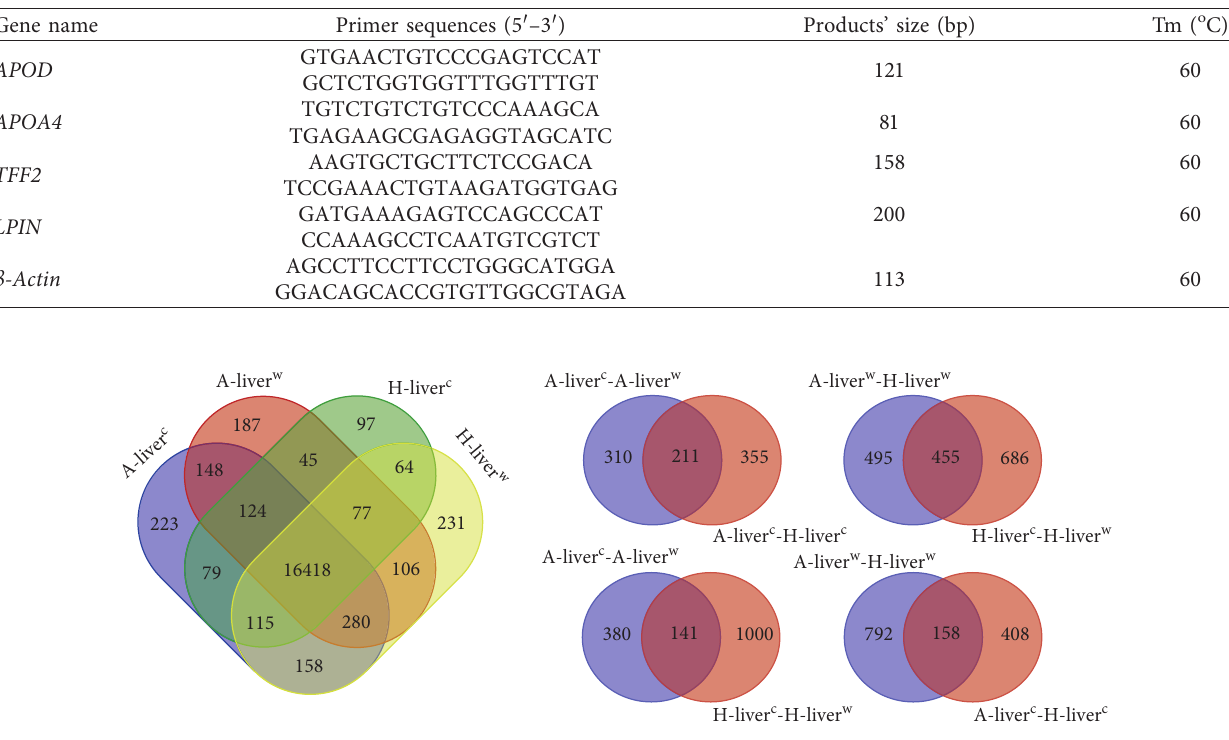
Table 1: Primer sequences of genes for RT-PCR validation.